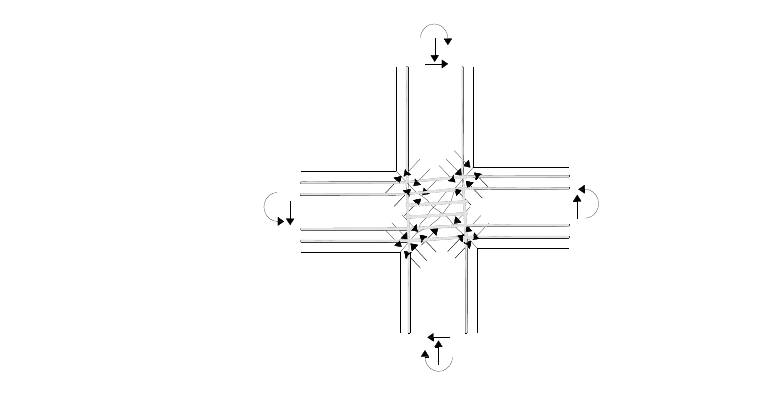
Figure 1. The basic scheme of original quadruple flexural resistance model (Shiohara